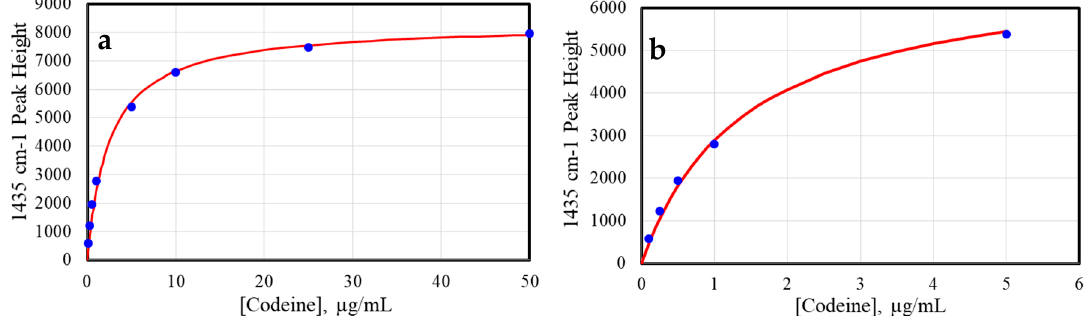
Figure 3. Plot of codeine 1435 cm − 1 peak height as a function of the concentration, fit with a Langmuir curve for ( a ) 100 ng/mL to 50 µg/mL, and ( b ) 100 ng/mL to 5 µg/mL.